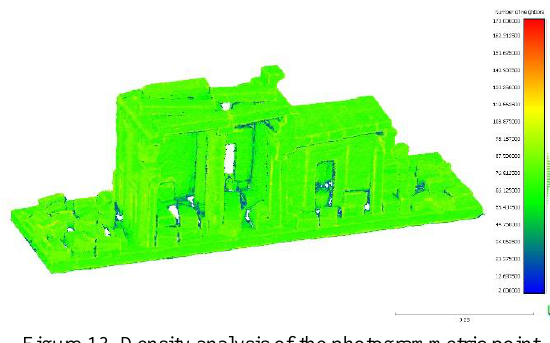
Figure 13. Density analysis of the photogrammetric point cloud